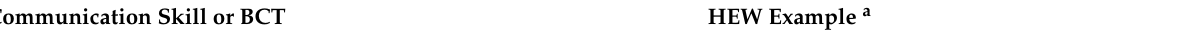
Table 3. Summary of Communication Skills and Behavior Change Techniques (BCTs) Observed in Video Recordings of Training